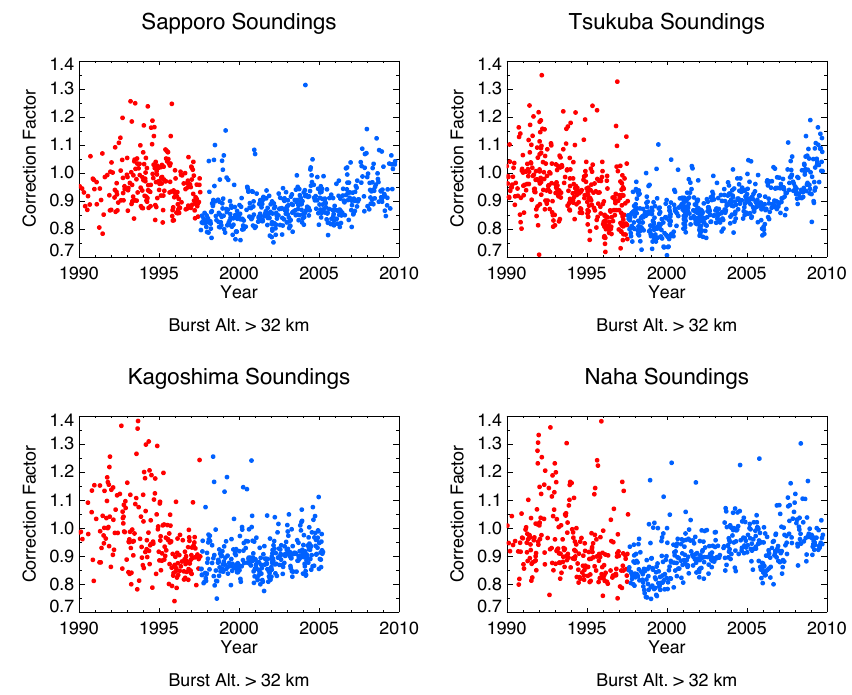
Fig. 4. CFs reported in the WOUDC data files as a function of time for all soundings from the Japanese stations that reach a burst altitude of at least 32km (10.5hPa). For Sapporo, Kagoshima, and Naha, ozonesondes changed from KC-79 to KC-96 in August 1997, while for Tsukuba, the change occurred in June 1997. CFs reached a minimum around the time of the change, were trending downward before the change, and have trended upward since the change at all four stations. See also Table 4 for calculations of these trends.